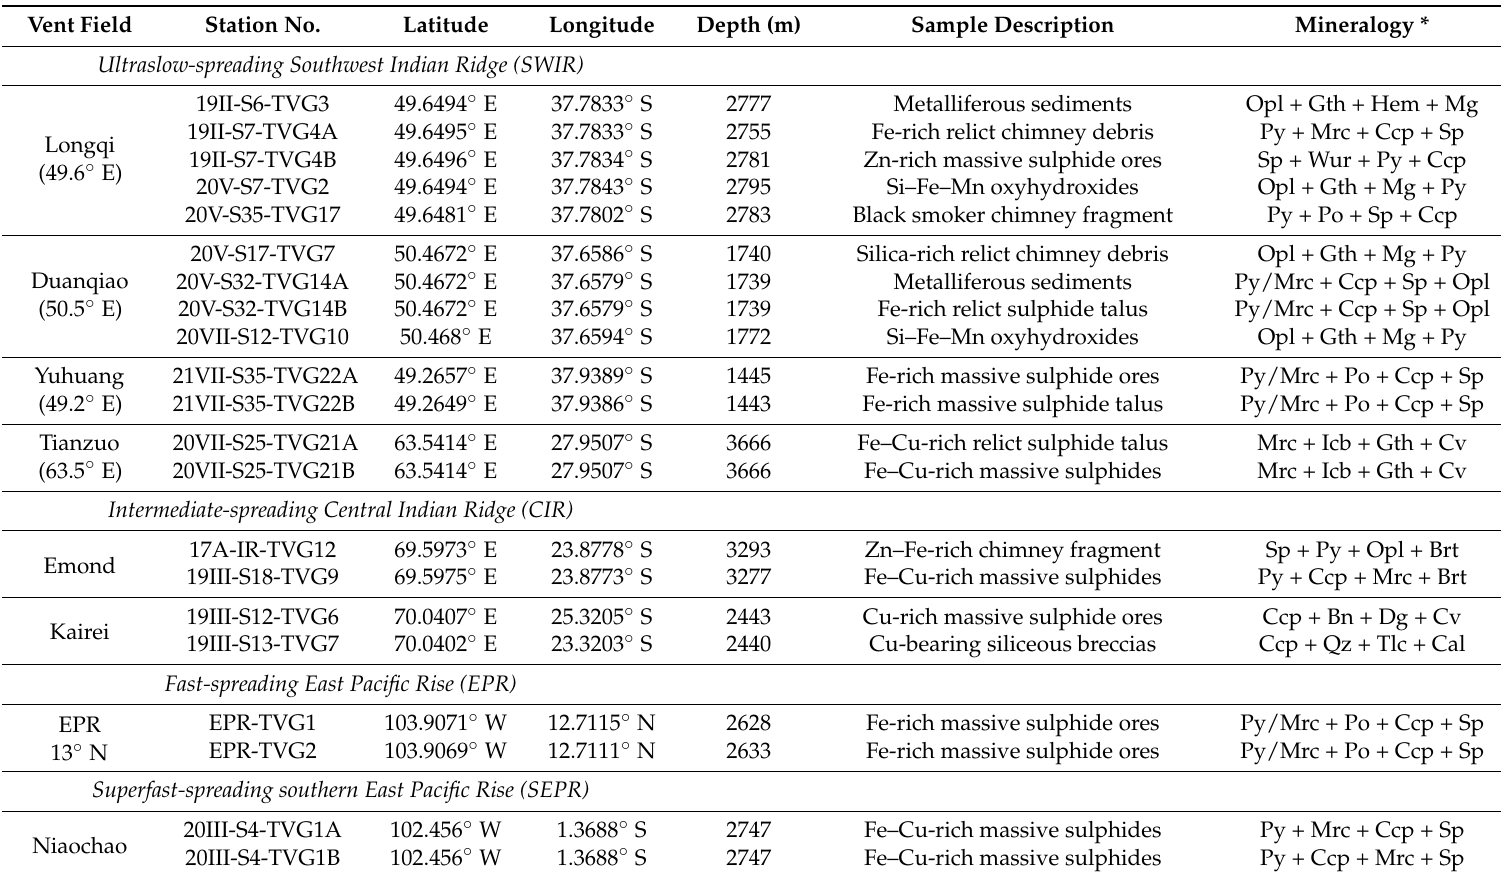
Table 1. Description of the Mid-Ocean Ridge polymetallic massive sulphides and hydrothermal sediment samples analysed for helium–argon and/or sulphur isotopic compositions in this